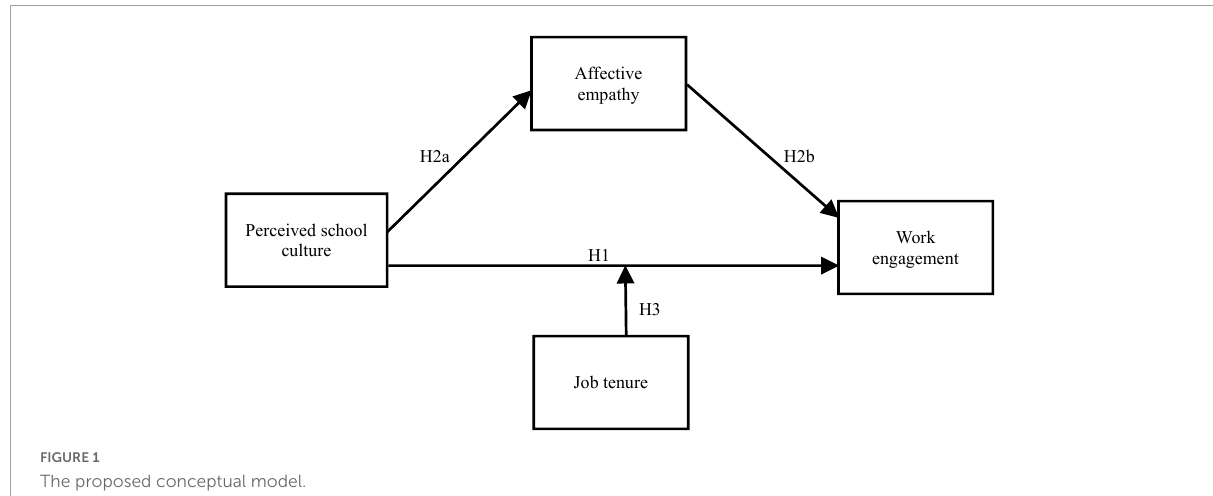
FIGURE1 The proposed conceptual